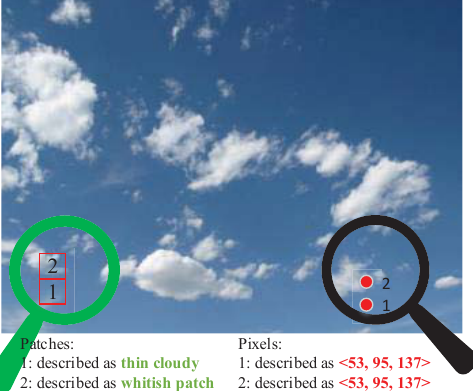
Figure 1. Sketch of the difference between pixels and patches. A pixel is encoded by a RGB vector, whose values are easy to be noised, and a pixel itself is not very meaningful. Meanwhile, a patch is more meaningful than a pixel and can be mapped to certain micro- structures, which are explainable with words.